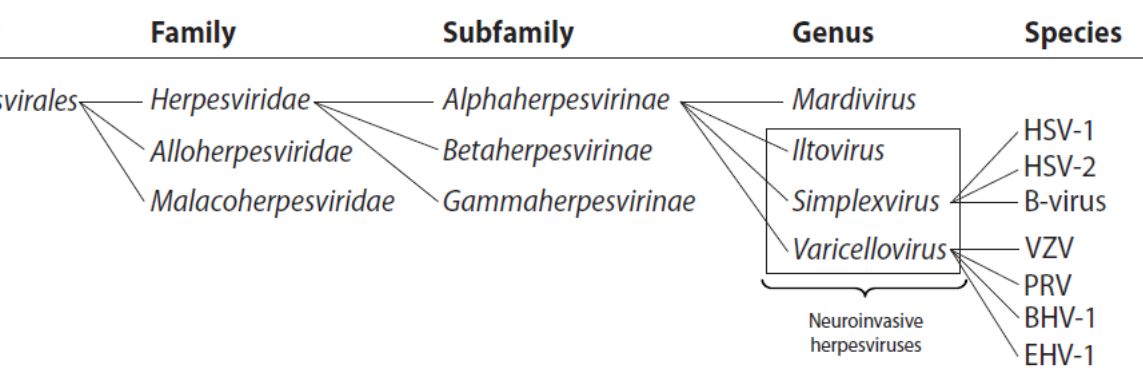
Figure 1. Taxonomy of neuroinvasive herpesviruses. Neuroinvasive herpesviruses include species from three genera of the Alphaherpesvirinae subfamily. Virus species mentioned in this review are as follows: herpes simplex virus type 1 (HSV-1) and type 2 (HSV-2); monkey B virus (B-virus); varicella-zoster virus (VZV); pseudorabies virus (PRV); bovine herpesvirus type 1 (BHV-1); equine herpesvirus type 1